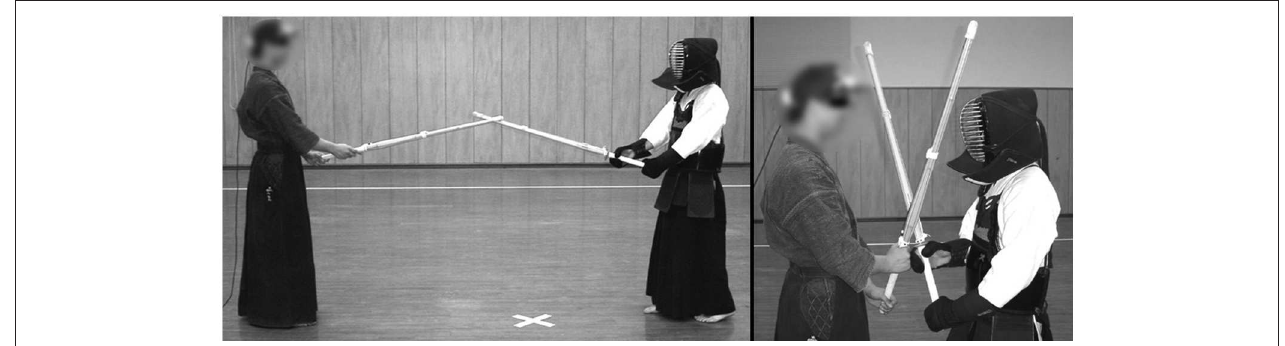
FIGURE 2 | Experiment scenes ( Left , common distance ∼ 2.5m between fighters in S1, S3, S4, and S5; Right , Tsubazeriai distance, which is extremely close, the swords were tangled, and the average interpersonal distance was ∼ 1m in